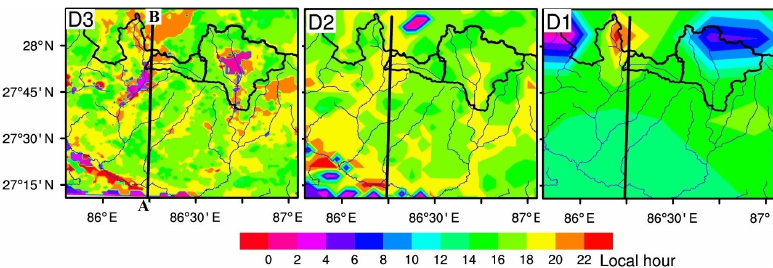
Figure 15. Peak precipitation hour (local time) simulated by three WRF resolutions. Rivers in the Nepal region are also delineated, with the political boundary of Nepal and Rolwaling (left) and Khumbu (right) catchment boundaries shown in black. Section AB is also drawn.